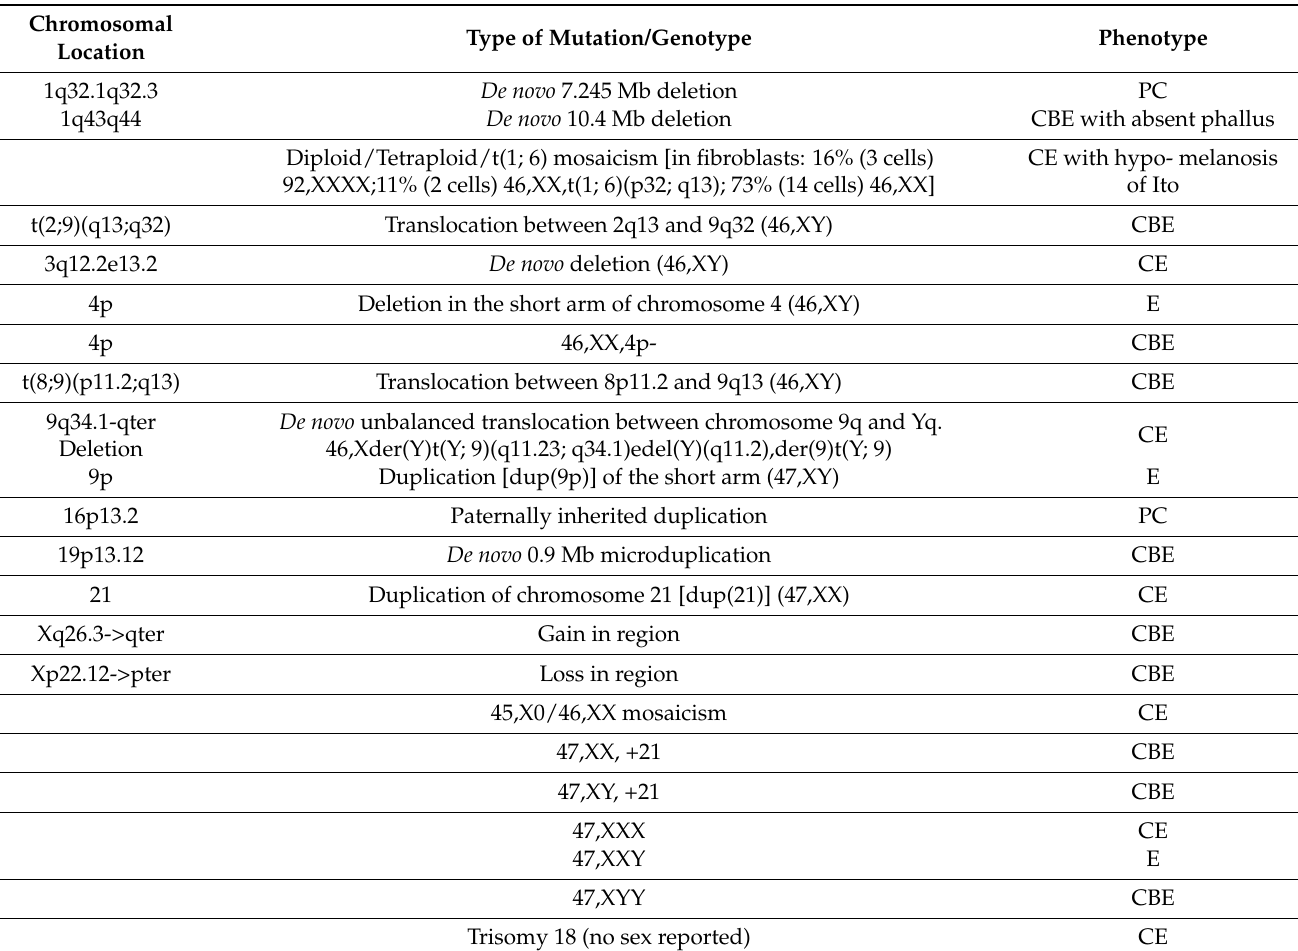
Table 2. Chromosomal anomalies in patients with BEEC adapted from Ludwig et al., 2009 [18]. Chromosomal Type of Mutation/Genotype Phenotype Location De novo 7.245 Mb deletion PC De novo 10.4 Mb